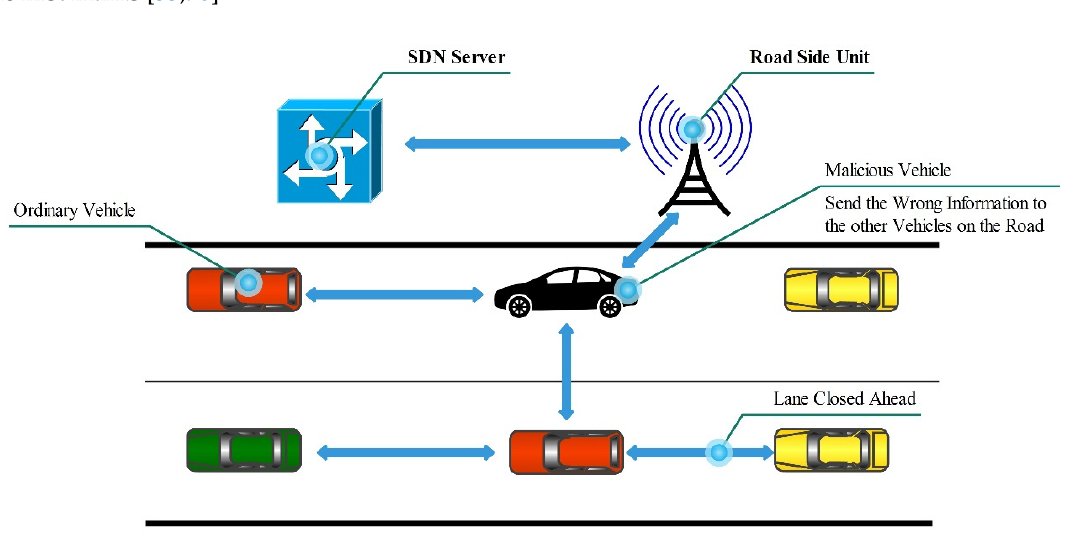
Figure 18. Man-in-the-middle attack (MiMA) in SDN-based VANETs.